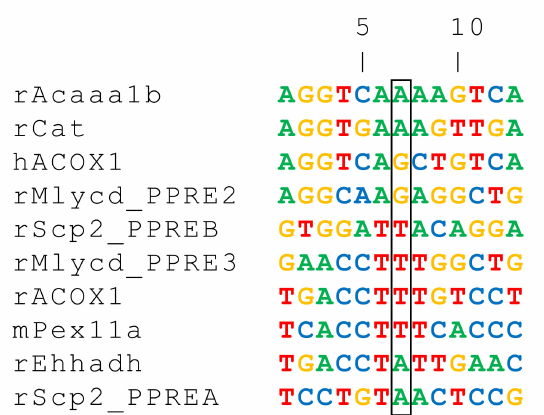
Figure 3. Multiple alignments of PPRE sequences, identified in peroxisomal gene promoters, and ex- perimentally proved to be regulated through PPAR α binding. Adenosine (A), cytidine (C), guanosine (G) and thymidine (T) nucleotides are respectively green-, blue-, yellow- and red-colored. Table 1. Peroxisomal genes experimentally proved to be regulated through the PPAR α binding to PPREs. Gene